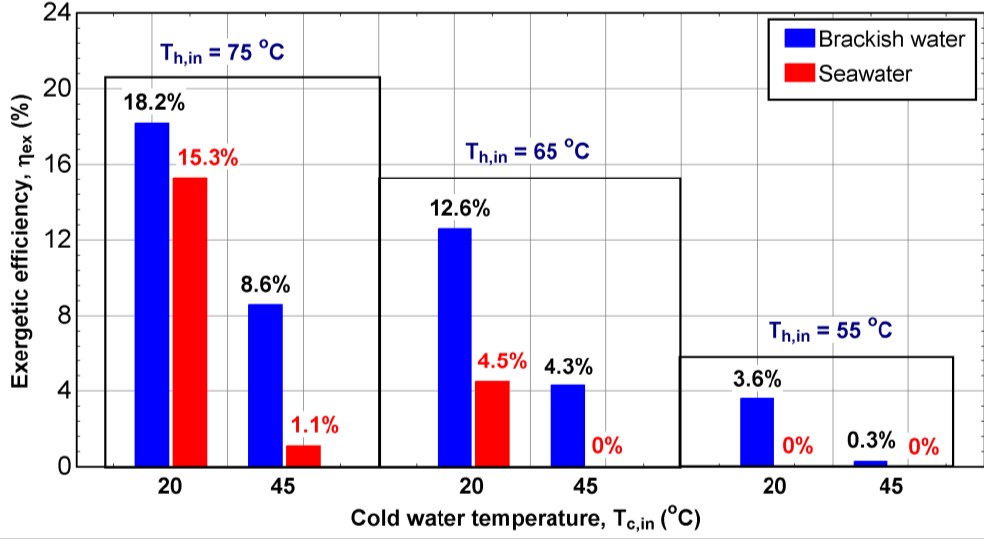
Figure 13. Variation of the exergetic efficiency for different inlet hot and cold water temperatures for brackish and sea waters ( 𝑉̇ ℎ = 840 L/h, 𝑉̇ 𝑐 = 405 L/h, 𝑉̇ 𝑓 = 87 L/h, T f , in = 25 °C, and P a , vac = 115 mbar).